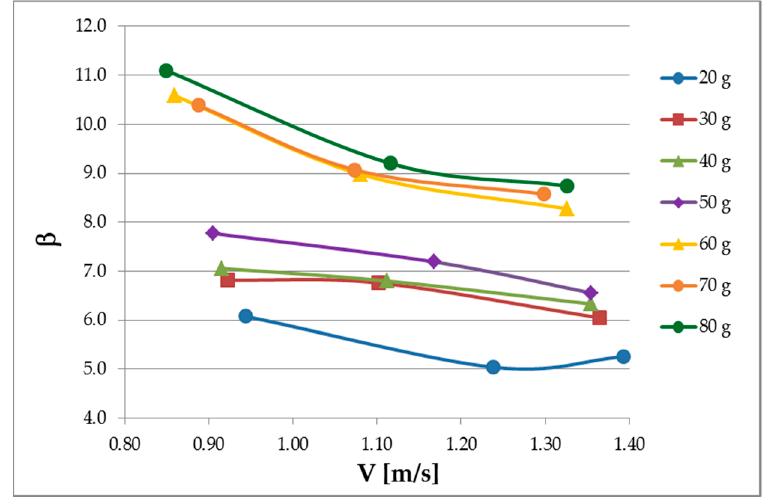
Figure 10. Values of coefficients β as functions of the velocities for all tests of clogging with fine sand.